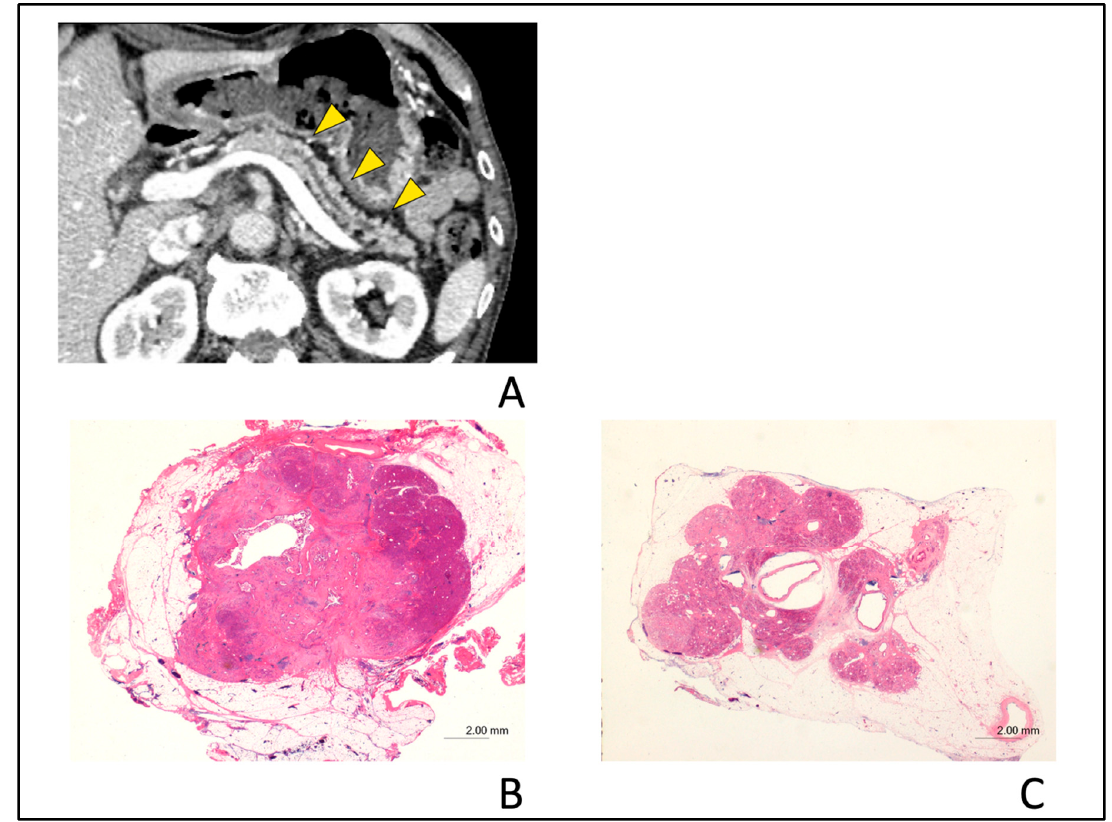
Figure 7. Typical computed tomography (CT) images showing upstream pancreatic parenchymal atrophy in a 72-year-old man with stage IA (tumor diameter of 10 mm in size) pancreatic cancer. Localized main pancreatic duct dilation was detected in the pancreatic body in the CT after the recurrence of acute pancreatitis and tumor lesion was detected in endoscopic ultrasonography. ( A ); Typical CT images showing upstream pancreatic parenchymal atrophy (PPA). The area exhibiting PPA has an atrophic change in the whole upstream side of the lesion (yellow arrow heads). ( B ); Hematoxylin and eosin (H&E)-stained resected specimen shows cancer nodule with a diameter of 10 mm in size (H&E stain, × 0.5 magnification). ( C ); Severe atrophy of pancreatic parenchyma and fatty change were observed in the upstream section from cancer nodule (H&E stain, × 0.5 magnification).